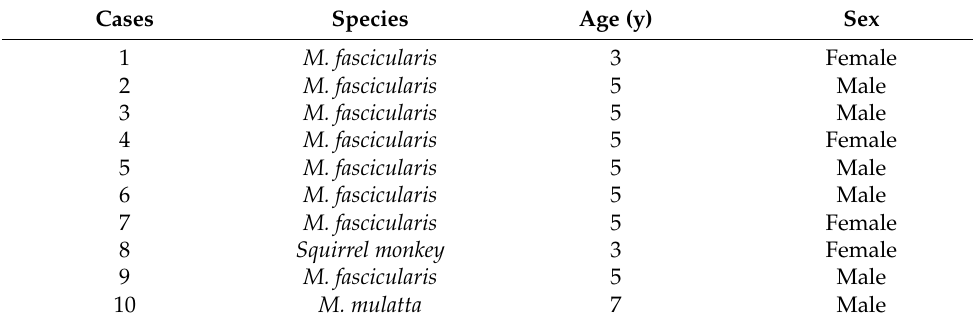
Table 2. Data of monkey brain